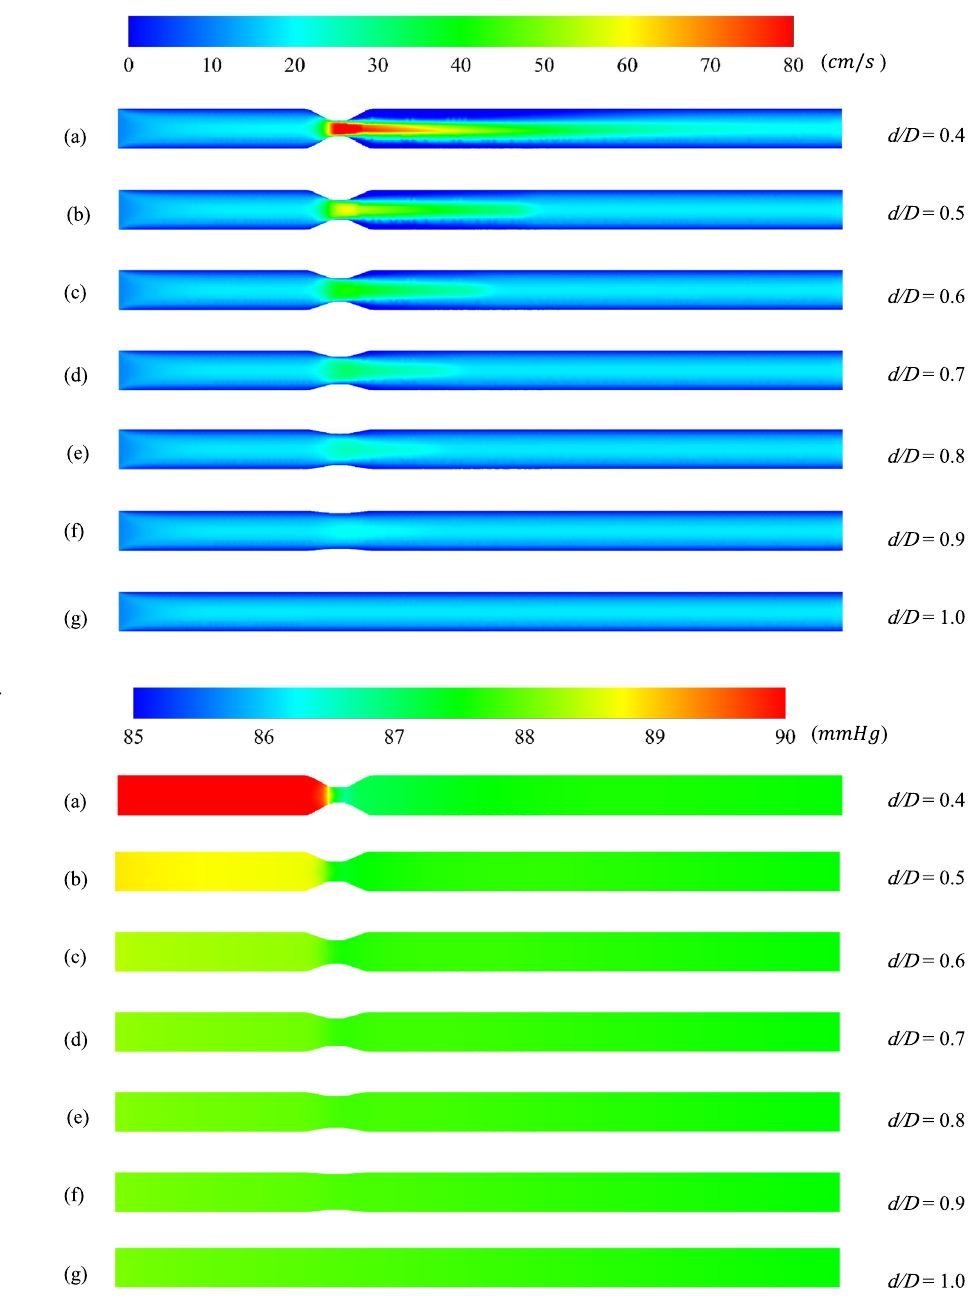
Fig. 5 Velocity distribution for case 1at different d/D